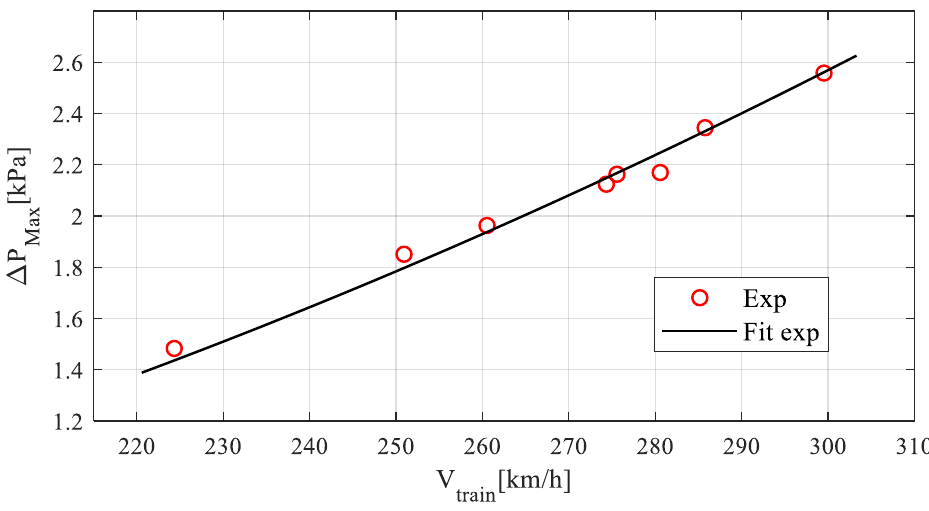
Figure 3. ∆ P max measure during the train speed increases as a function of the speed and best fit quadratic line.